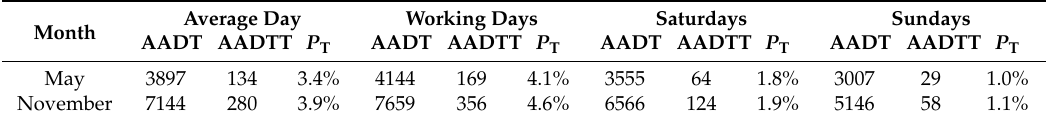
Table 3. White styrene acrylic painting specifications.